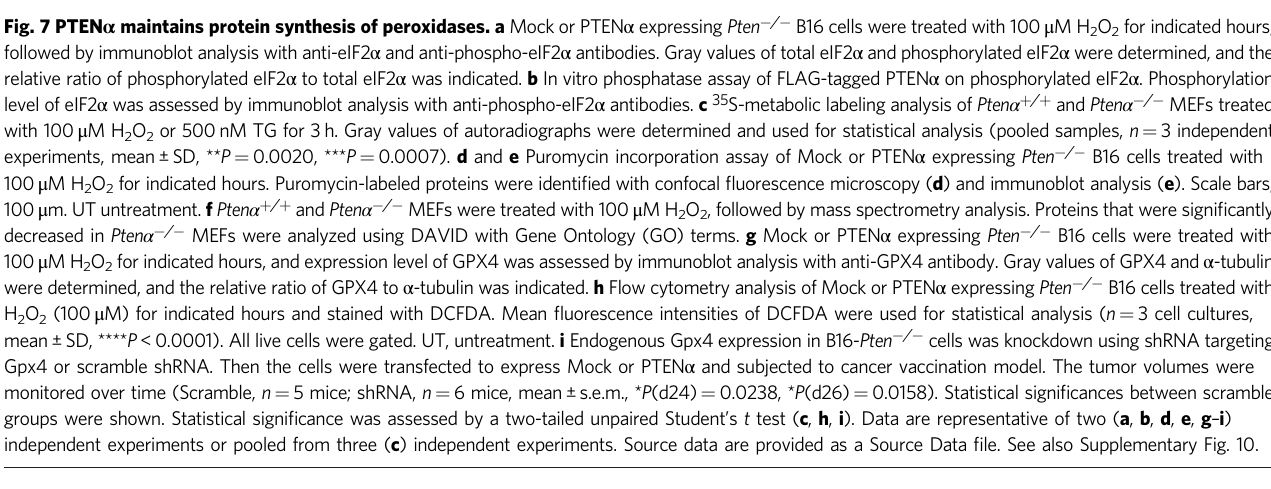
Fig. 7 PTEN α maintains protein synthesis of peroxidases. a Mock or PTEN α expressing Pten − / − B16 cells were treated with 100 μ M H 2 O 2 for indicated hours, followed by immunoblot analysis with anti-eIF2 α and anti-phospho-eIF2 α antibodies. Gray values of total eIF2 α and phosphorylated eIF2 α were determined, and the relative ratio of phosphorylated eIF2 α to total eIF2 α was indicated. b In vitro phosphatase assay of FLAG-tagged PTEN α on phosphorylated eIF2 α . Phosphorylation level of eIF2 α was assessed by immunoblot analysis with anti-phospho-eIF2 α antibodies. c 35 S-metabolic labeling analysis of Pten α + / + and Pten α − / − MEFs